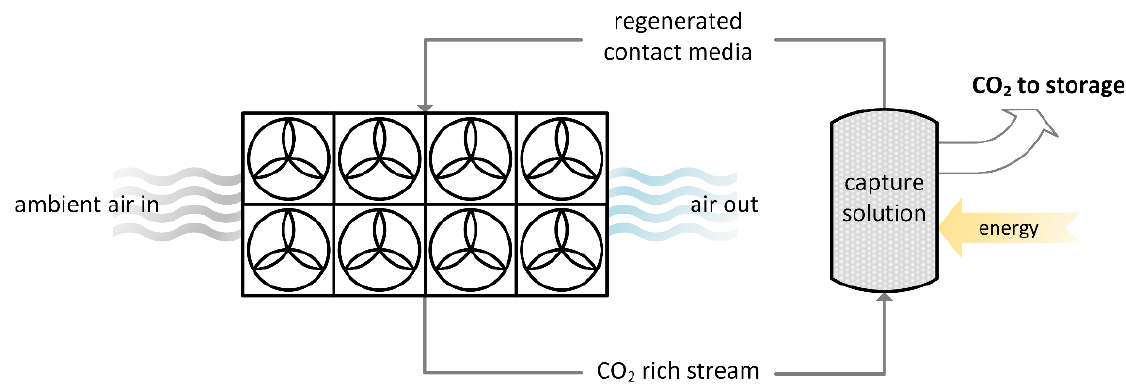
Figure 4. General principle of Direct Air Capture (adapted from [18]).